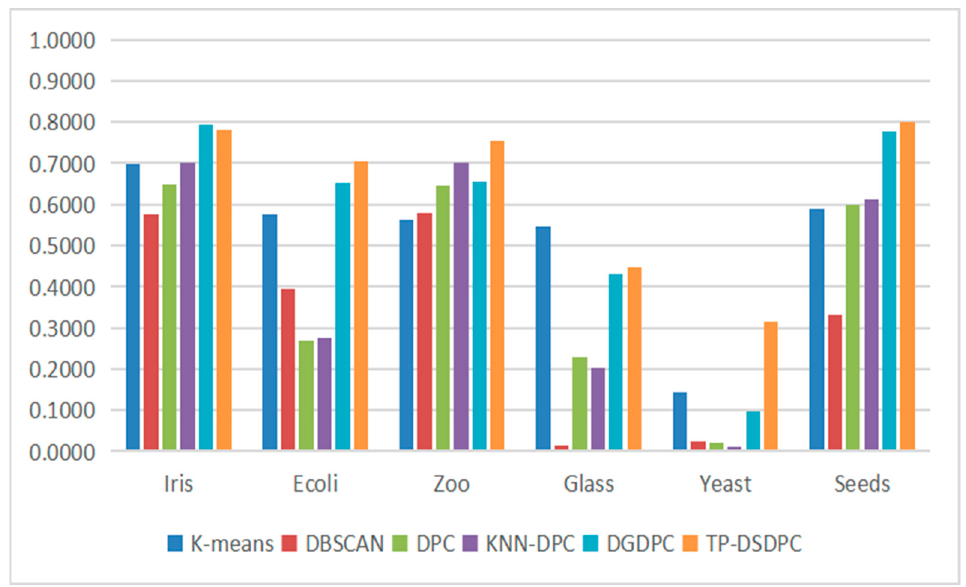
Figure 16. The ARI of the six algorithms on six real-world datasets.